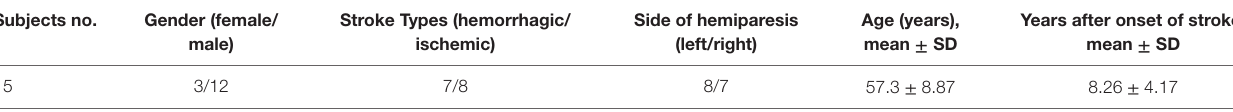
TaBlE 1 | Demographic characteristics of the stroke subjects. Subjects no.